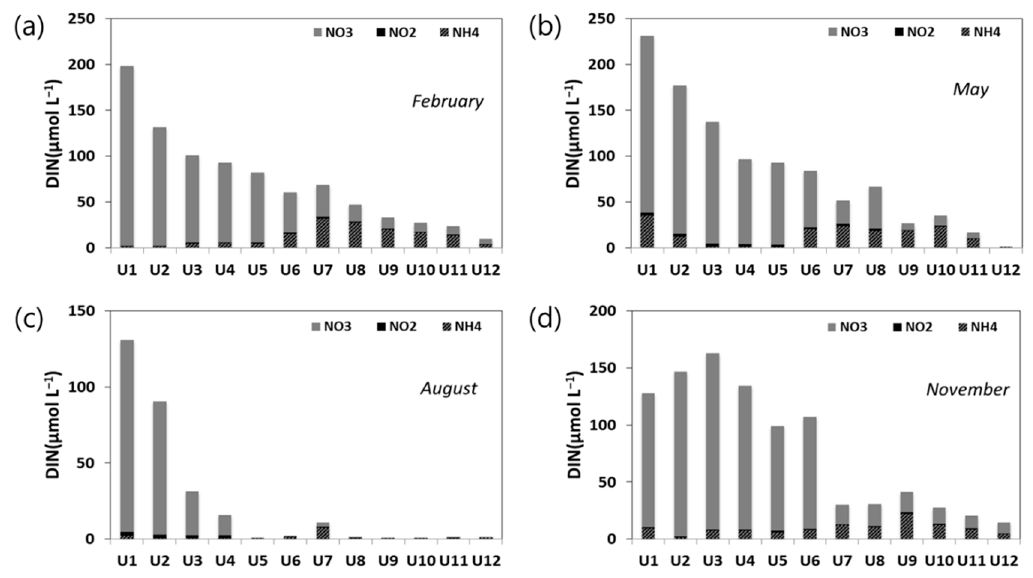
Figure 5. The rates of dissolved inorganic nitrogen (DIN, the sum of ammonium, nitrite, and nitrate) at different stations in the Taehwa River estuary in Korea. ( a ) February, ( b ) May, ( c ) August, and ( d ) November.